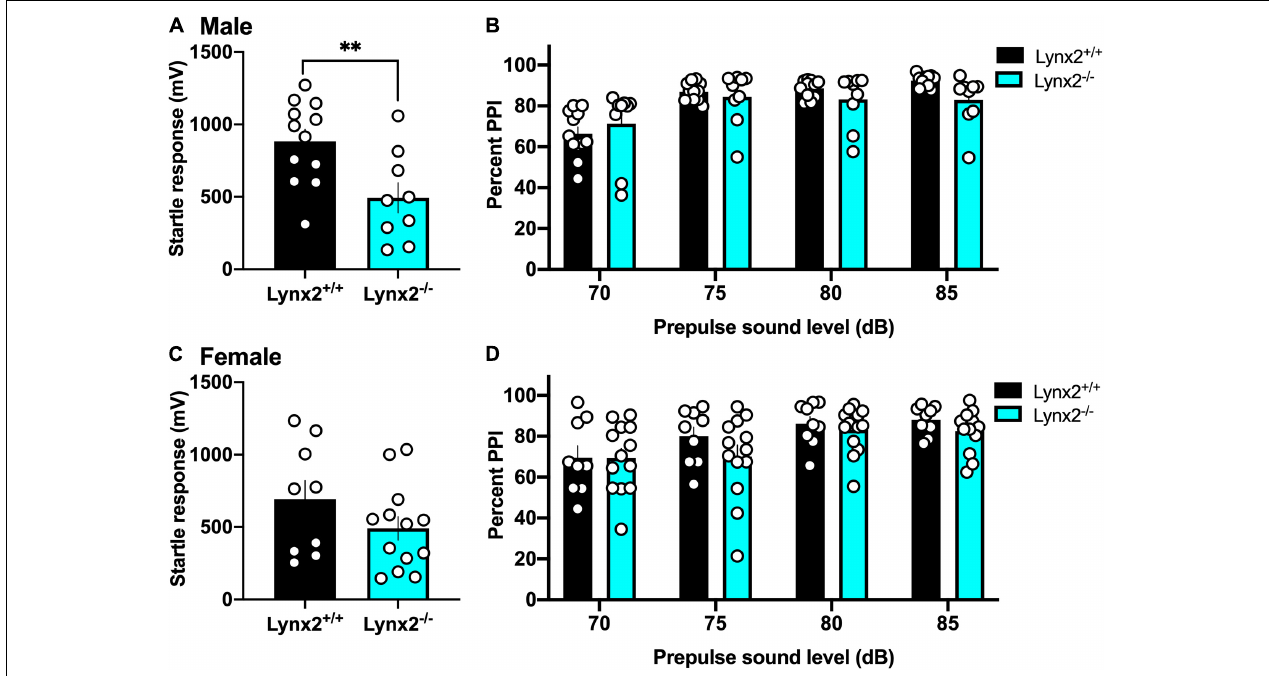
FIGURE 7 | Lack of association between lynx2 and sensorimotor gating. (A) For the baseline startle response, male lynx2 − / − and lynx2 + / + mice ( n = 9–12/group) were examine, and the lynx2 − / − exhibited a decrease in their startle reactivity compared to lynx2 + / + littermates. (B) Following the presence of a prepulse, male lynx2 − / − mice exhibited no differences in their percent PPI compared to the lynx2 + / + mice. (C,D) Female lynx2 − / − and lynx2 + / + mice ( n = 9–13/group) exhibited no differences in the baseline startle response (C) or percent PPI (D) . ∗∗ p < 0.01. Individual data points shown as white circles, and the bars represent mean ±